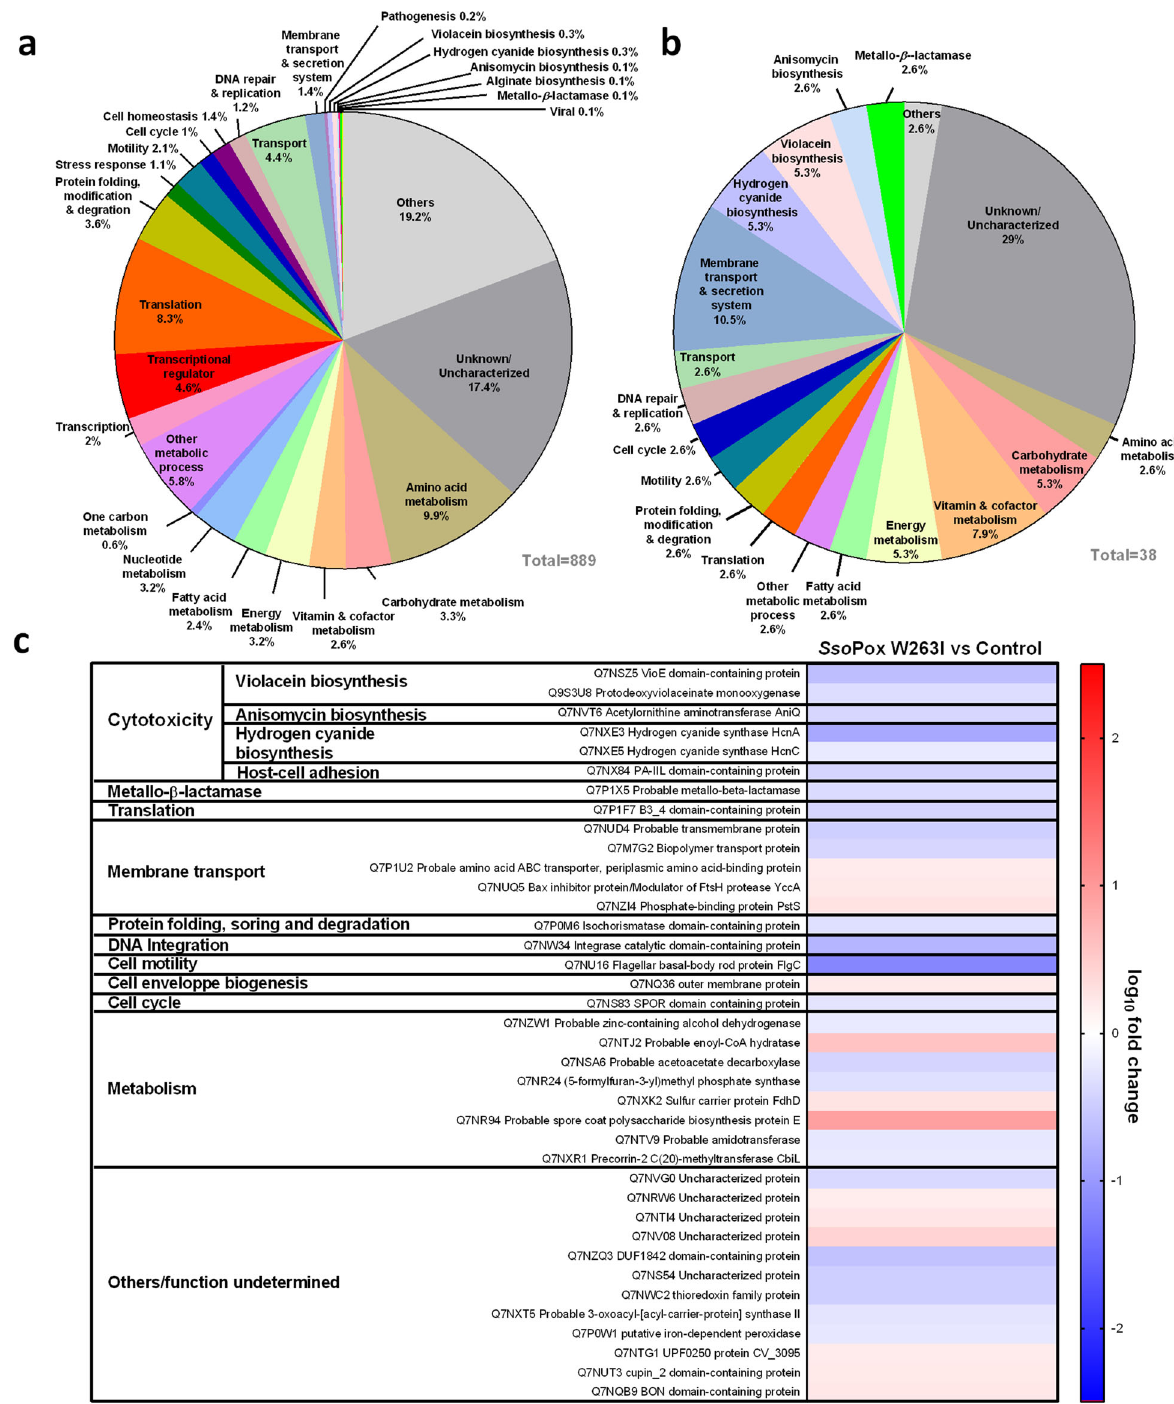
Fig. 2 Proteome analysis of C. violaceum cultures with and without lactonase treatment. a Functional distribution of all proteins detected in C. violaceum samples. b Functional distribution of proteins signi fi cantly impacted by Sso Pox W263I treatment. c Impact of Sso Pox W263I treatment on C. violaceum protein production. Heatmap represents the log 10 fold change in protein production of Sso Pox W263I-treated samples as compared to untreated ones as negative controls (selection criteria for signi fi cantly impacted proteins were P value <0.05 and fold change ≥ 1.5). Down- and upregulated protein expressions are presented in blue and red,